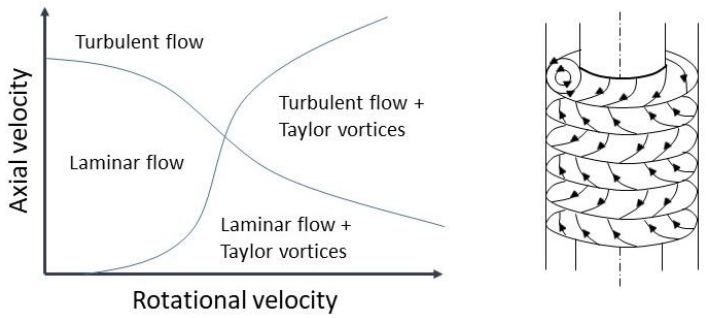
Figure 1. Appearance of the four main flow modes according to the axial and rotational velocity magnitudes in an air gap ( left ) and the basic form of Taylor vortices ( right ).